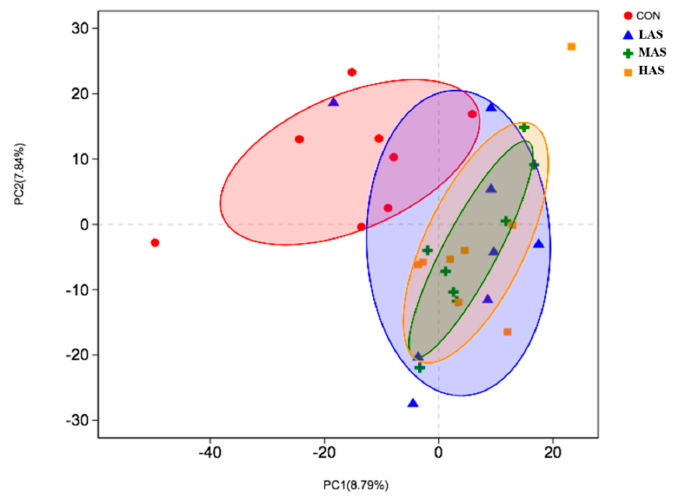
Figure 3. Principal component analysis of bacterial communities in different groups. CON-S (%DM)